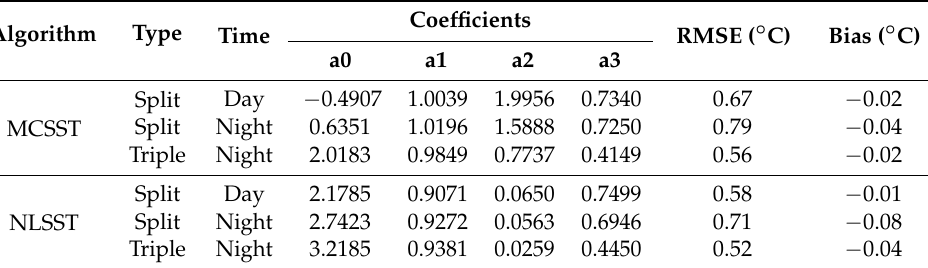
Table 4. Coefficients of MCSST and NLSST algorithms in the Equations (1)–(4) and root mean squared errors (RMSEs) and bias